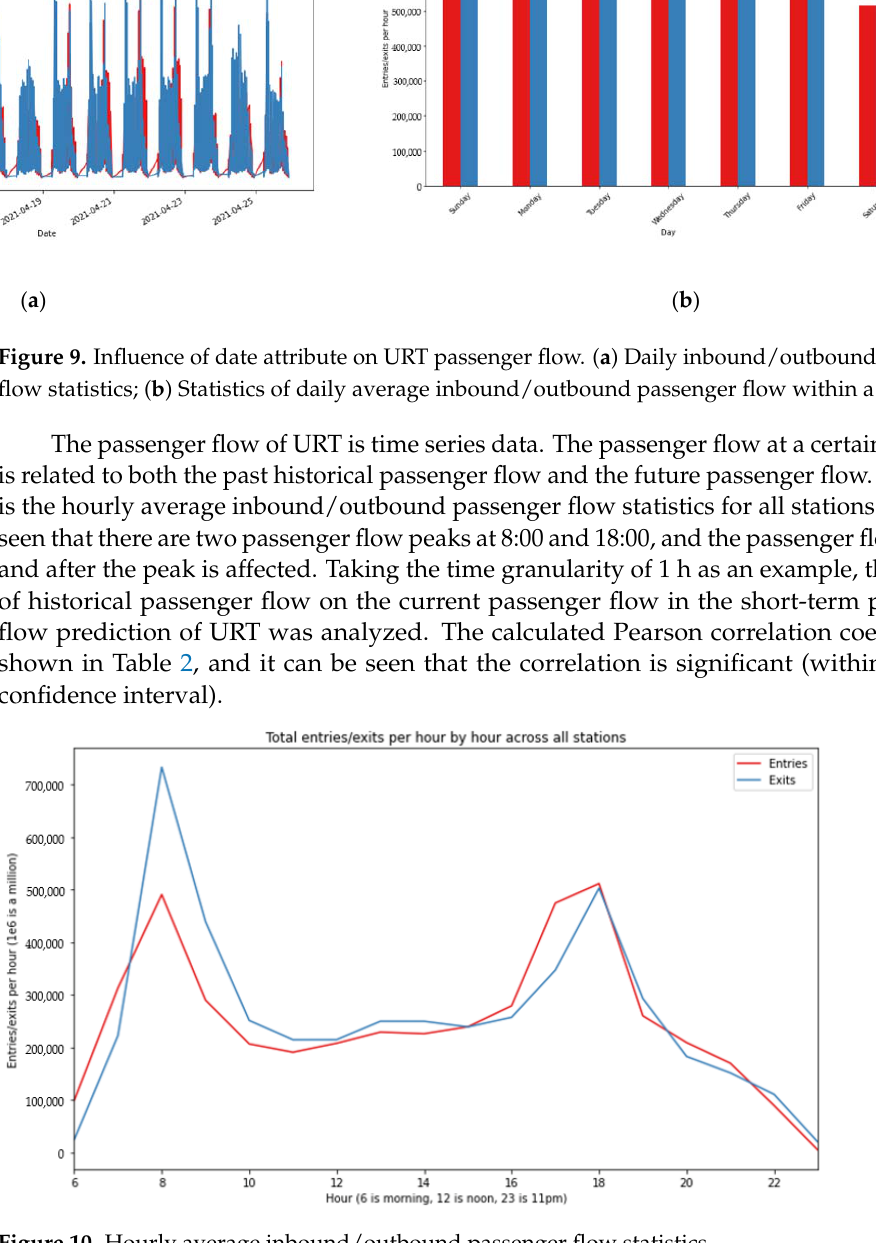
Table 3. Influencing parameters of passenger flow analysis and prediction.